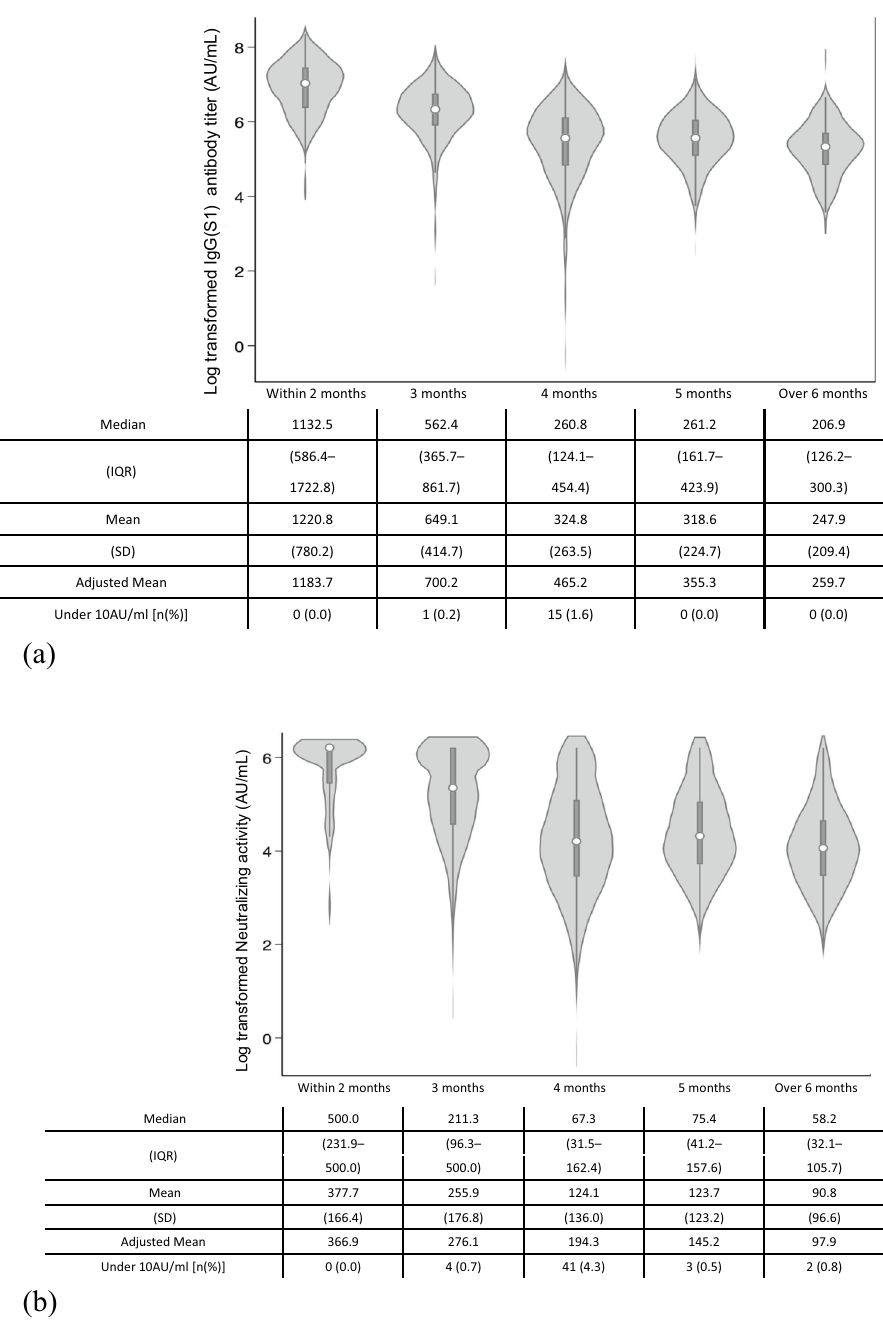
Figure 3. Distribution of ( a ) IgG antibody titer against S1 protein and ( b ) neutralizing activity by groups based on duration from second vaccination. Anti-S1 IgG antibody and neutralizing activity were log-transformed. The cut-off values of each antibody were 10 arbitrary units per milliliter (AU/mL). The adjusted mean titer was calculated using the age distribution of the whole country’s population based on the Japanese model population in 1985 (we do not have the new version of the model